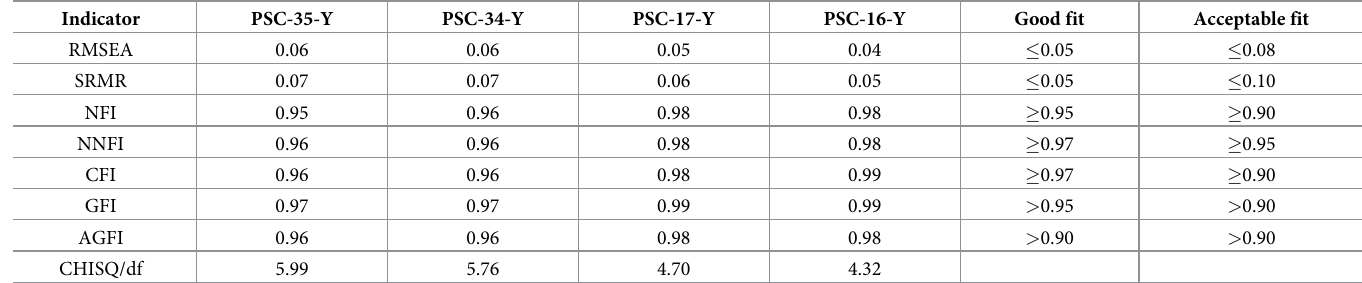
Table 4. Model fit indices of CFA.